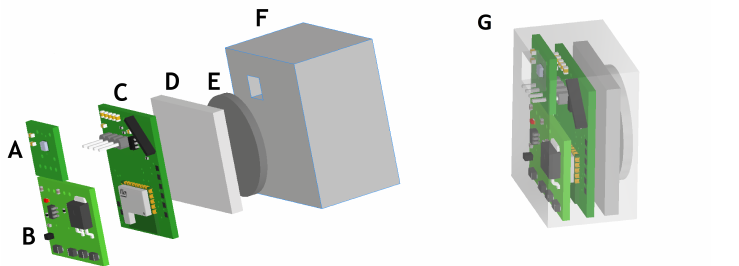
Figure 2. 3D model of the mechanical implementation for the device. ( A ) BME280 PCB ( B ) Power management unit PCB ( C ) Microcontroller and wireless communication unit PCB. ( D ) LiPo battery.